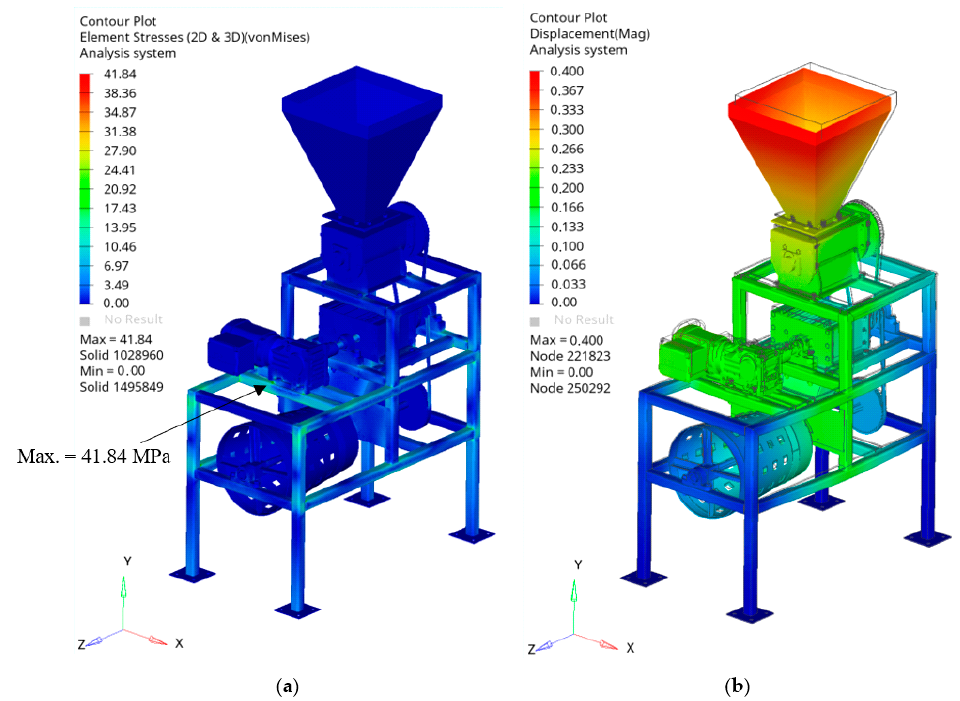
Figure 20. ( a ) Von Misses stresses contour (MPa) in static load case; ( b ) resultant displacements (mm) in static load case, scaled 500×.